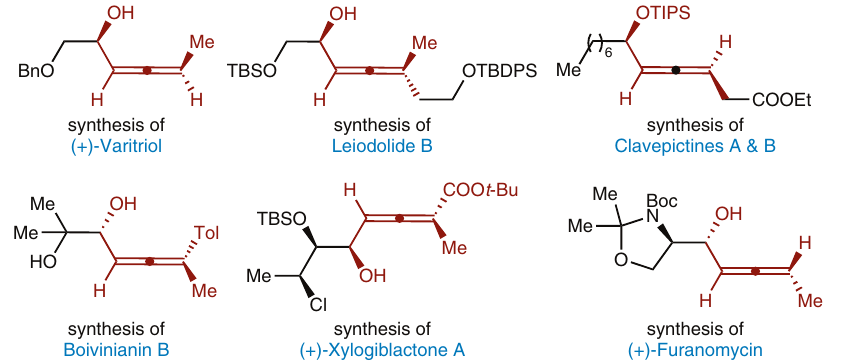
Fig. 2 | The importance of chiral allenols. Bn benzyl, TBS tert -butyldimethylsilyl, Me methyl, TIPS triisopropylsilyl, Et ethyl, Tol p -methylphenyl, t -Bu tert -butyl, Boc tert